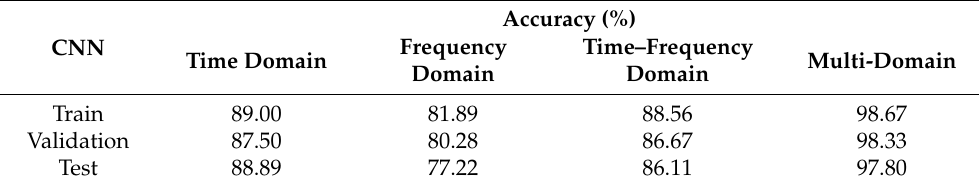
Table 10. Comparison of recognition results for different domain